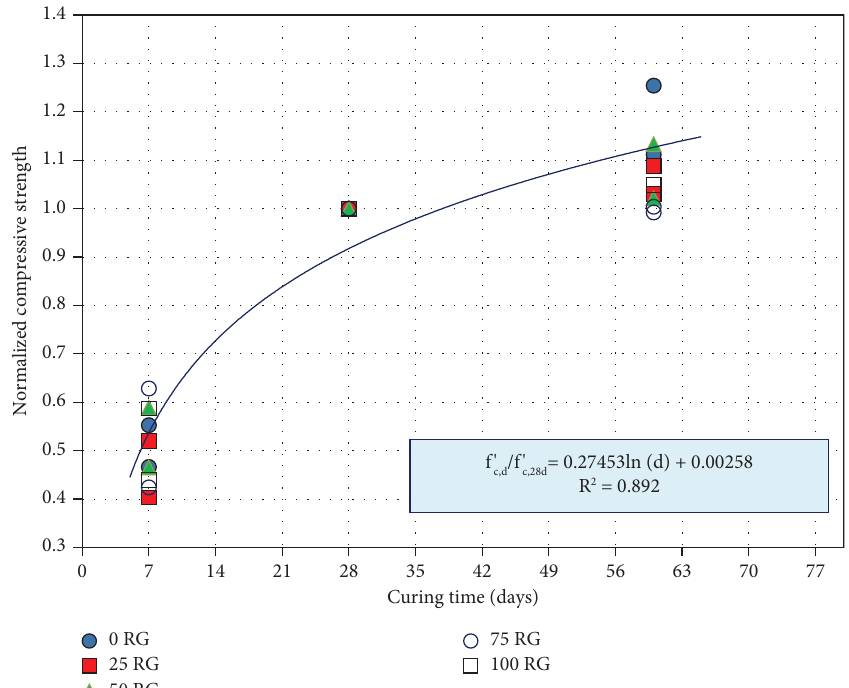
Figure 5: Relationship between normalized compressive strength and curing time of AAFA mortar containing RG by the 28-day compressive strength.